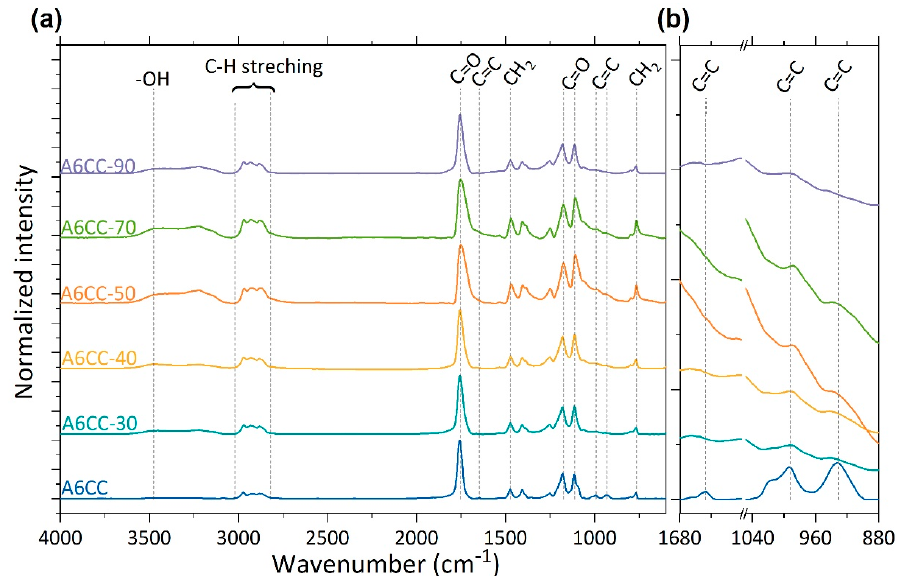
Figure 2. Representative FTIR spectra of the A6CC liquid layers as a function of the number of runs, up to 90, of plasma exposure (power: 1.60 W · cm − 2 ). ( a , b ) zoom of the bands attributed to the allyl C-C double bond. The spectra were normalized with respect to the peak of the carbonate carbonyl